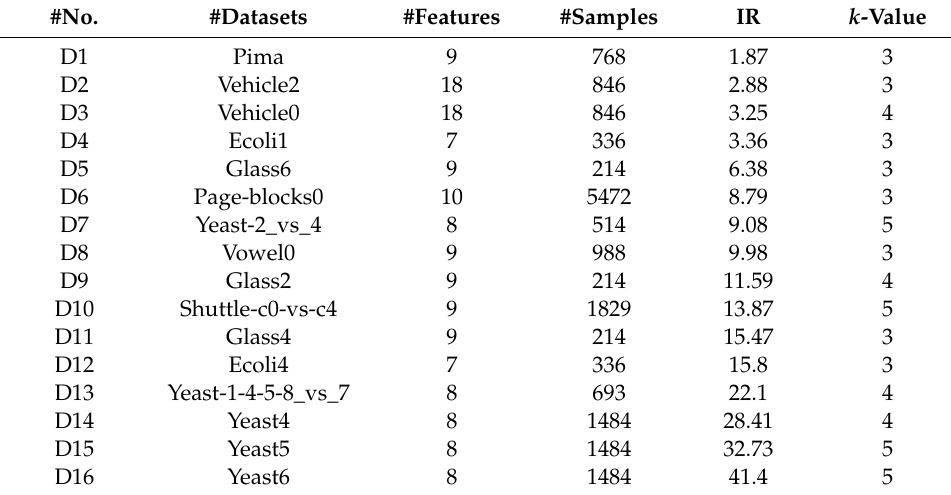
Table 1. Summary of 16 imbalanced datasets.